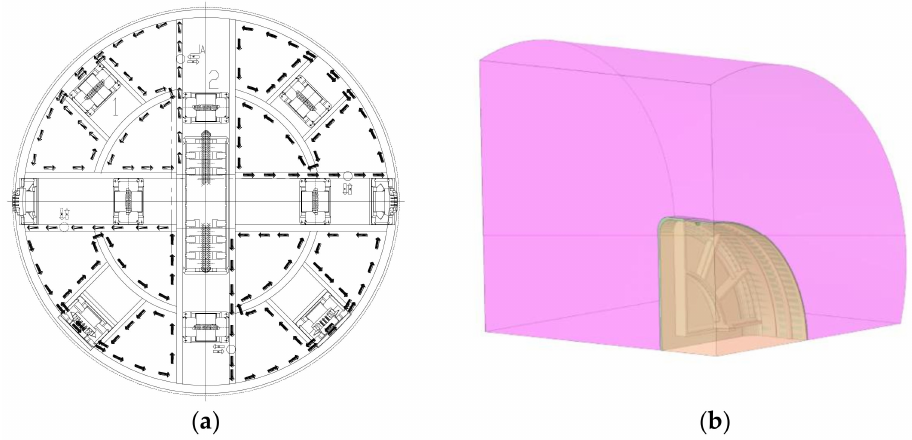
Figure 3. Geometric model of the frozen soil system of the cutter head. ( a ): Geometric model of the cutter head; ( b ): Frozen soil system of the cutter